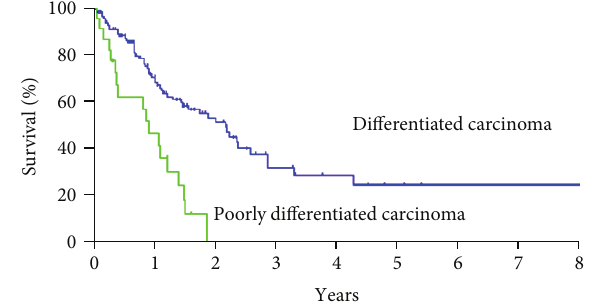
Figure 3: Survival curves of patients with differentiated and poorly differentiated carcinomas. MST and 5-year survival rate were 25.9 months and 24.6% in patients with differentiated carcinoma, but those in patients with poorly differentiated carcinoma were 10.7 months and 0% ( 𝜒 2 = 16.955 , 𝑃 < 0.001 ).